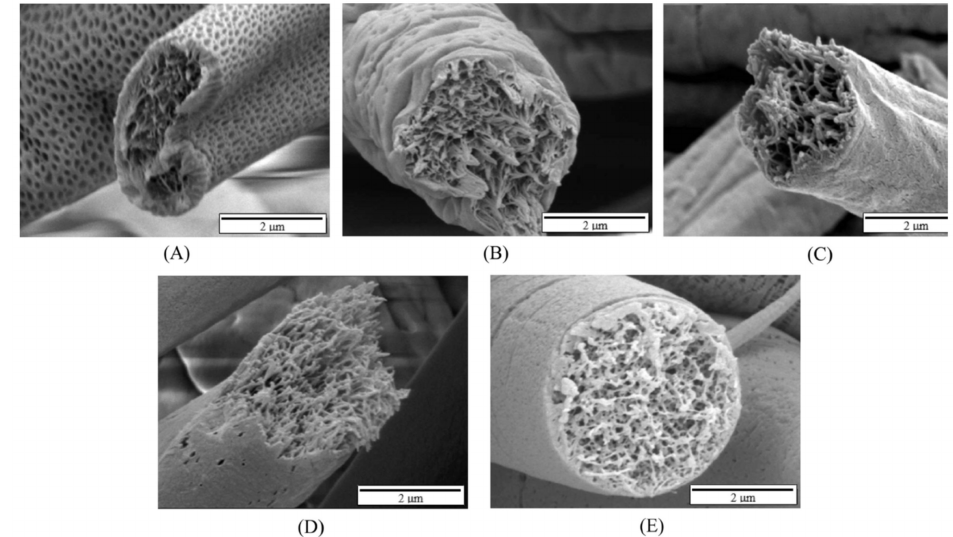
Figure 2. Filed emission scanning electron microscopic images showing the cross-sections of the electrospun polystyrene fibers from the solutions with different weight ratios of tetrahydrofuran / dimethylformamide: ( A ) 4 / 0, ( B ) 3 / 1, ( C ) 2 / 2, ( D ) 1 / 3, and ( E ) 0 / 4. Reprinted with permission from [38]. Copyright © 2010 American Chemical